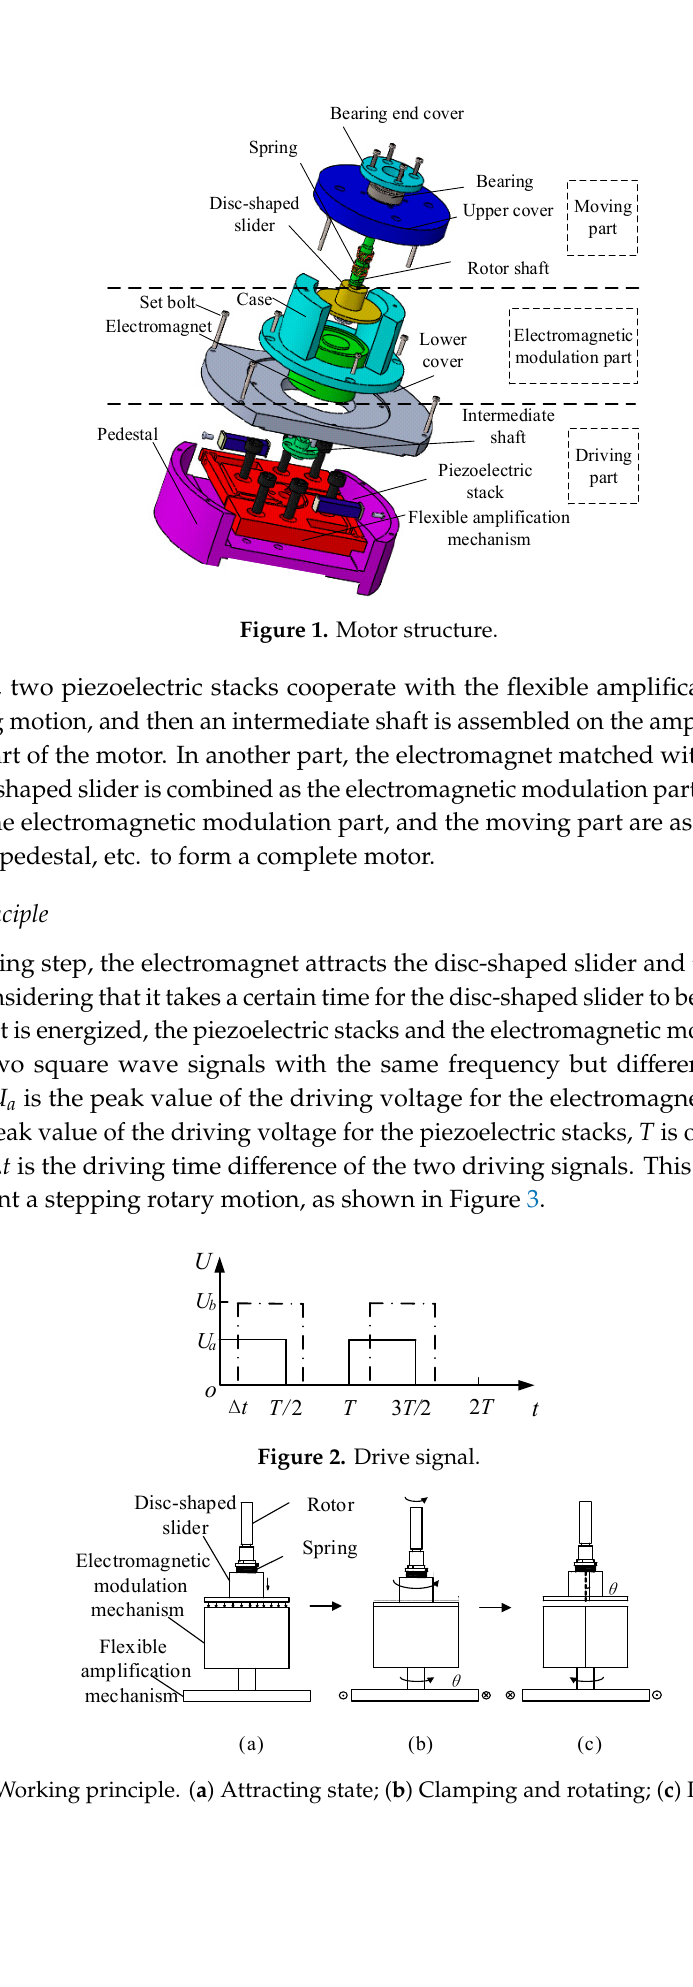
Figure 3. Working principle. ( a ) Attracting state; ( b ) Clamping and rotating; ( c ) Restoring state.